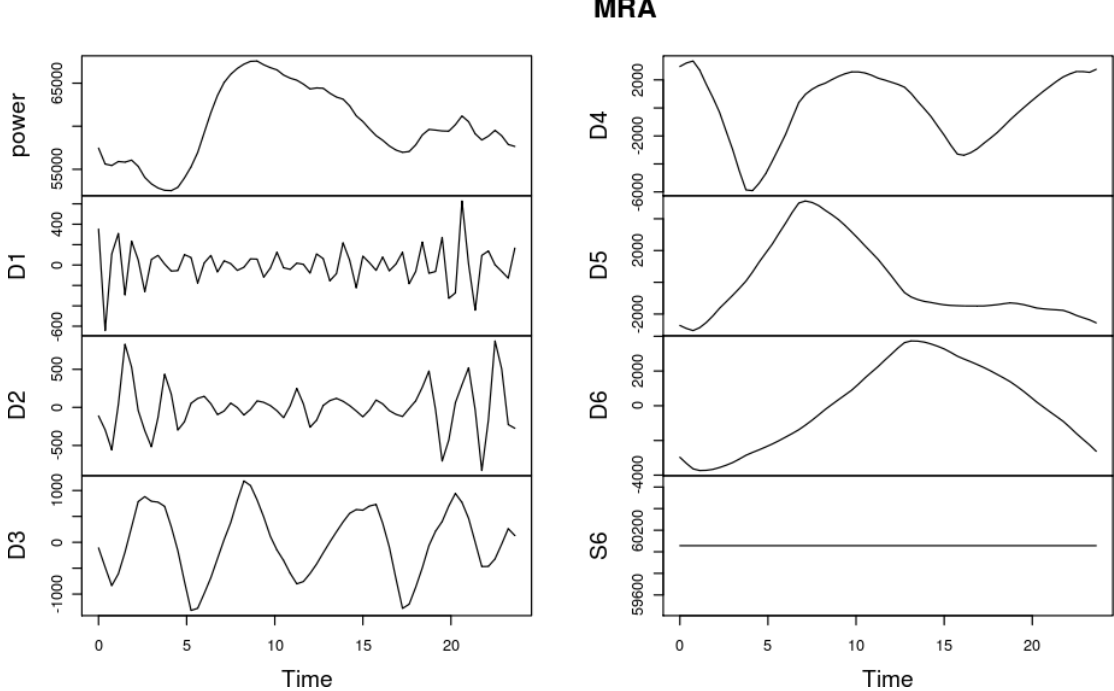
Figure 5. Multiresolution